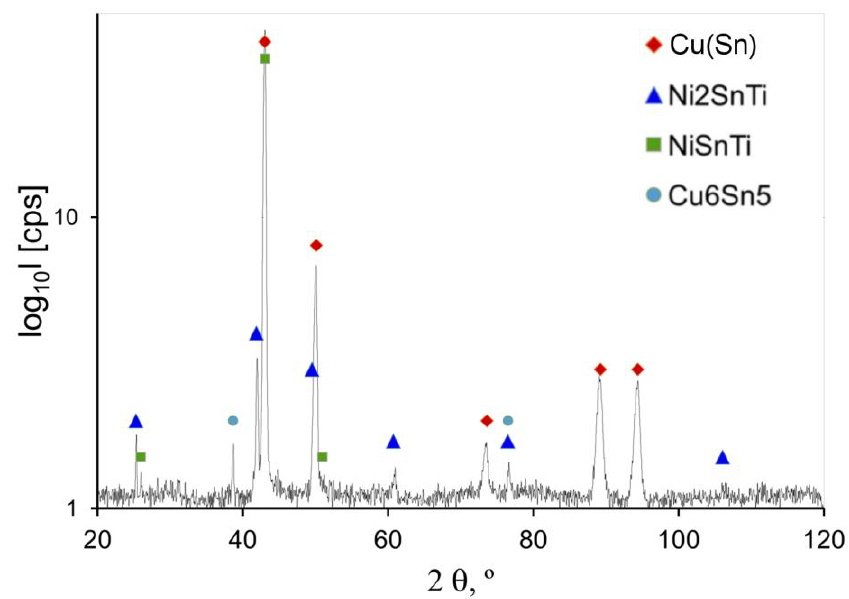
Figure 9. Powder diffraction spectrum of the CuSn8Ni3Ti2 alloy. The results of mechanical tests i.e., tensile strength (UTS), elongation (A) and hard- ness (HBS) are presented in Figure 10 and Table 8.